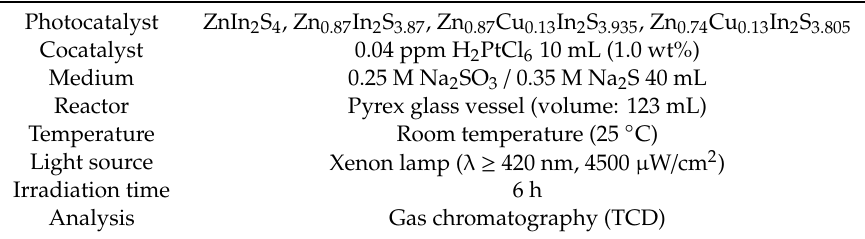
Table 1. Hydrogen generation experimental conditions.